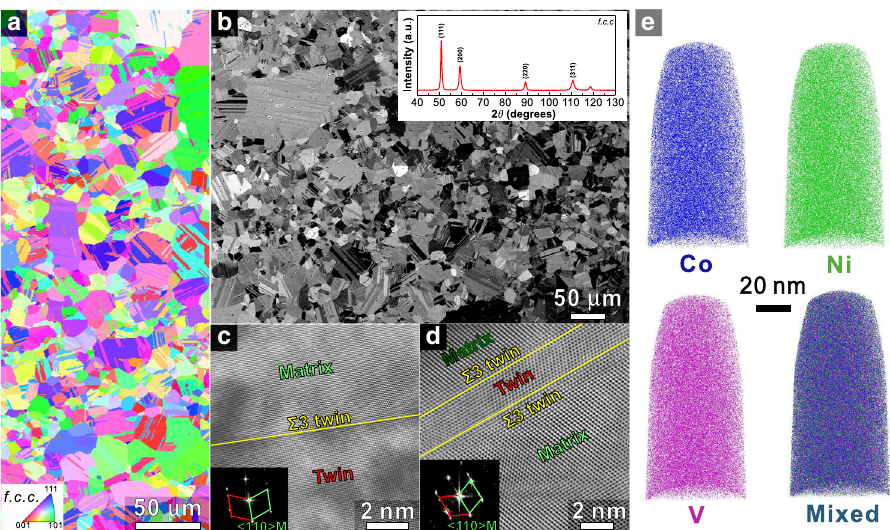
Fig. 1 Recrystallization microstructures of the equiatomic CoNiV MEA. a IPF map. b ECC image with inserted XRD pattern. c , d High angle annular dark- fi eld (HAADF) images of twins and the corresponding selected area diffraction (SAD) patterns. e 3D reconstructions of a typical APT tip. XRD X-ray diffraction, IPF inverse pole fi gure, ECCI electron channeling contrast imaging, APT atom probe tomography.